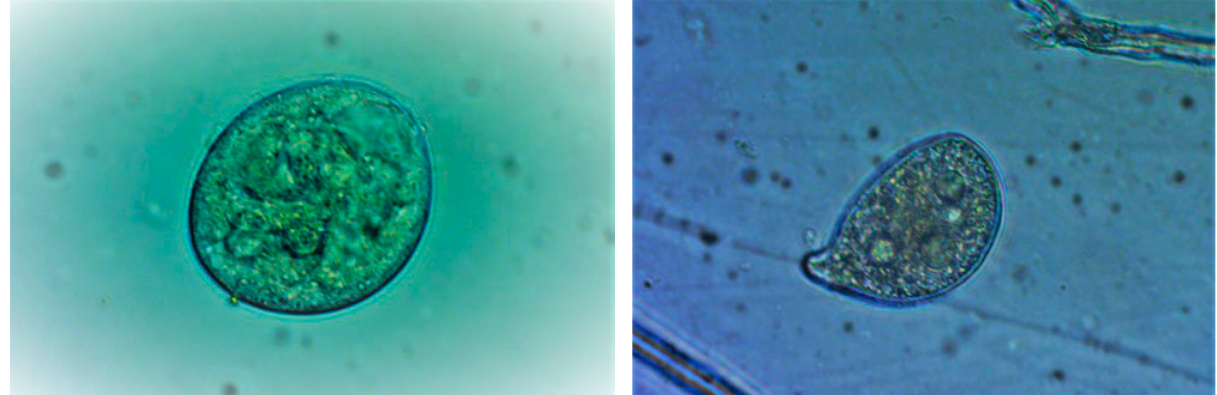
Figure 7. Asci of Erysiphe elevata , sessile (a) or on a short stalk